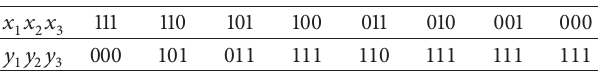
Figure 2: Transition diagram of the PDS [𝐺, 𝐹] . Table 1: Lookup table for the time-one-map of the PDS [𝐺, 𝐹]